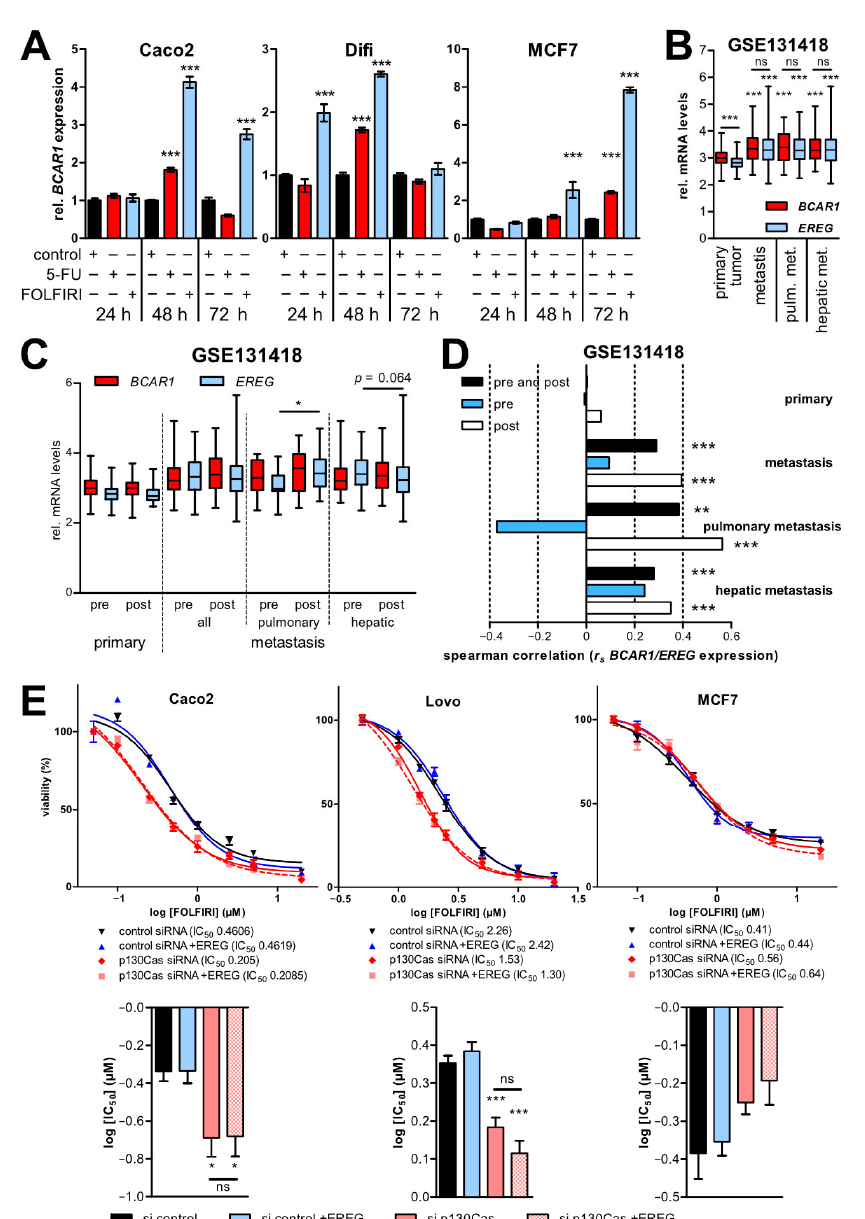
Figure 4. p130Cas/ BCAR1 and EREG expression are upregulated in distant metastases, and BCAR1 downregulation sensitizes CRC cells to FOLFIRI. ( A ) Cells were seeded in 6-well plates and treated after 1 d with vehicle control, 5-FU (20 µ M) or FOLFIRI (20 µ M 5-FU) for indicated times. BCAR1 mRNA expression was quantified with RT qPCR. Shown are expression levels in relation to vehicle control (set to 1) from one representative out of three performed experiments. ( B – D ) BCAR1 and EREG levels in patient samples of the GSE131418 data set were analyzed. Patient numbers for each investigated subgroup are presented in Table S3B. ( C ) BCAR1 and EREG expression in pre- and post-treatment patient samples. ( D ) BCAR1 / EREG expression correlation calculated with Spearman correlation. Spearman coefficients ( r s ) are presented. ( E ) Cells were transfected with control or p130Cas siRNA and subsequently incubated with or without recombinant EREG (12.5 ng/mL) and increasing concentrations of FOLFIRI. Cell viability was measured with AlamarBlue assays. Shown are results from one representative out of three performed experiments. IC 50 values are indicated. Lower panels, significant differences between response curves were estimated by one-way ANOVA and Bonferroni’s multiple comparison post-test approach. ( A – E ) ns, not significant. * p < 0.05. ** p < 0.01. *** p < 0.001. IC50, half-maximal inhibitory